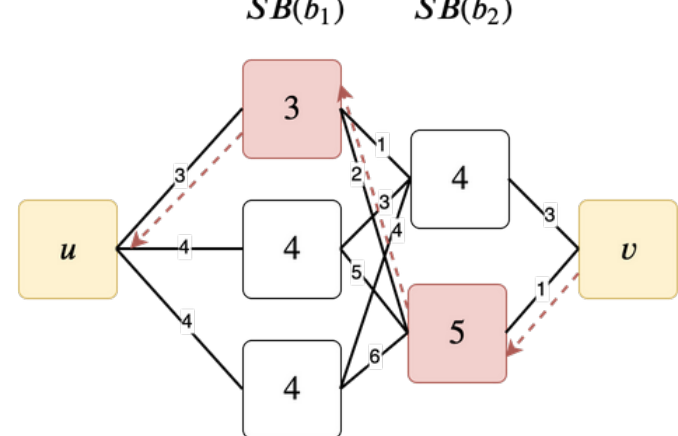
Figure 6. An example of border